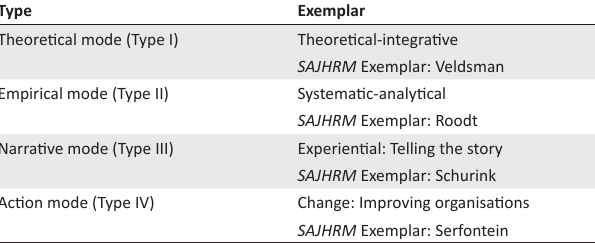
TABLE 4: Four foundational types of knowledge